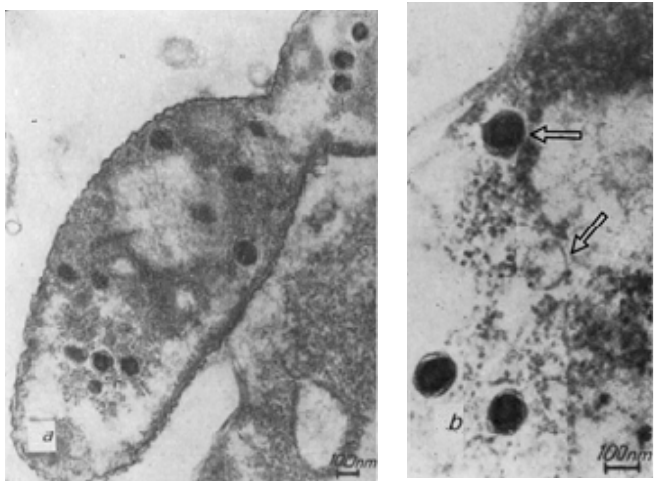
Figure 2. P. aeruginosa bacterium (ultrathin section), 120 min after phiKZ infection. ( a ) A whole cell section of P. aeruginosa; ( b ) P. aeruginosa cell section fragment. Phage heads may represent different stages in phiKZ morphogenesis and DNA compaction (see arrows)